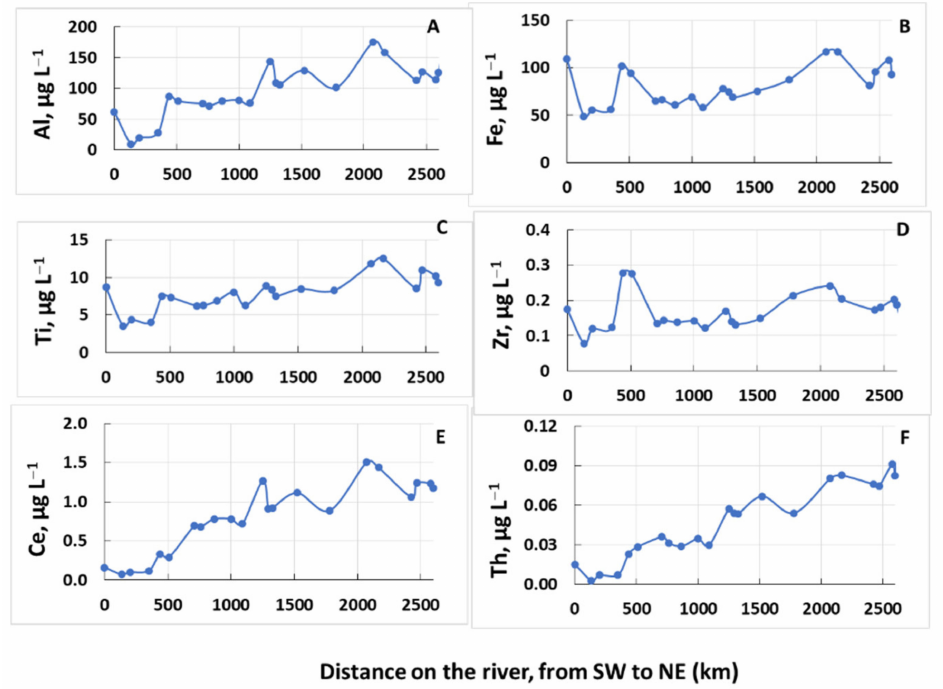
Figure 3. Examples of elements increasing their concentration in the main stem of the Lena River from SW to NE: Al ( A ), Fe ( B ), Ti ( C ), Zr ( D ), Ce ( E ) and Th ( F ). The distance is km of river from Zhigalovo (0 km, upper reaches) to the Aldan River (2600